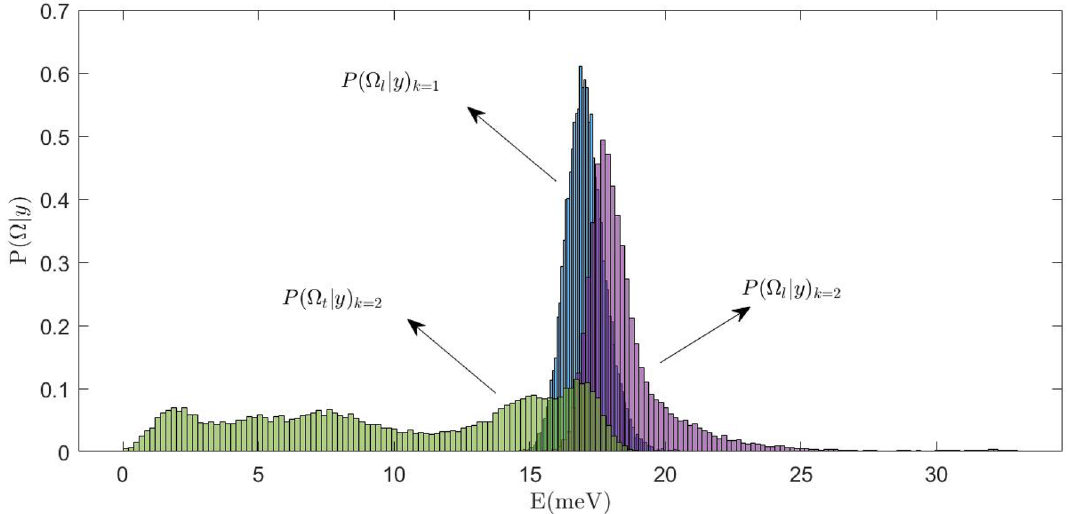
Figure 7. Three posterior distributions from the analysis of the spectrum at Q = 16 nm − 1 are plotted. P (� l y ) k 1 (in blue) is the conditional probability for the longitudinal frequency when the model with k = 1 | = y ) k is chosen. P (� l / t 2 are the conditional probabilities for the frequencies which might be associated to the | = transverse mode (in green) and to the longitudinal mode (in violet)